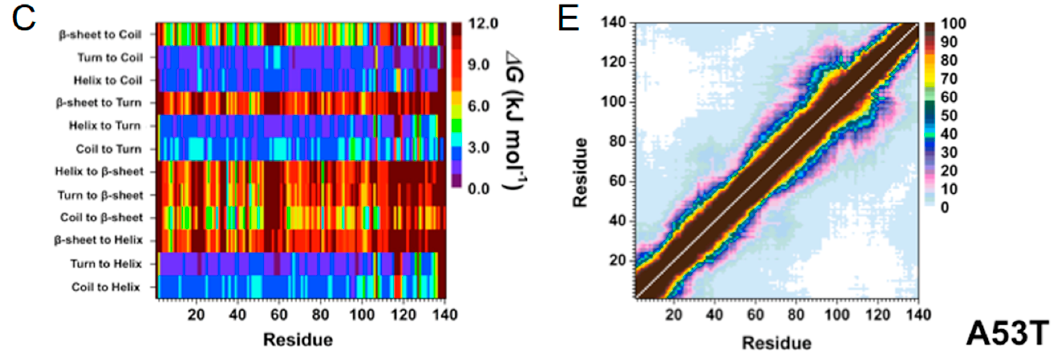
Figure 1. ( A ) WT and A53T Mutant α S Secondary Structure Components. Secondary structure component abundances per residue for the WT (black) and A53T mutant (red) α S structures obtained after convergence. The abundances for the π -helix and coil structures are not displayed; ( B ) WT and A53T Mutant α S Secondary Structure Transition Stabilities. The stability of secondary structure transitions between two specific secondary structure components per residue for the WT (WT) and A53T mutant (A53T) α S proteins based on free energy calculations performed using a recently developed theoretical strategy; TISS. The color scale corresponds to the free energy value associated with the specific secondary structure transition between two secondary structure components for a specific residue; ( C ) WT and A53T Mutant α S Tertiary Structures. Calculated intra-molecular interactions of the WT (WT) and the A53T mutant (A53T) α S. The color scale corresponds to the probability (P) of the distance between the heavy atoms (C, N, O, S) of a residue being ≤ 20 Å from each other; ( D ) the tertiary structure map for the WT α S and ( E ) the tertiary structure map for the A53T mutant α S.